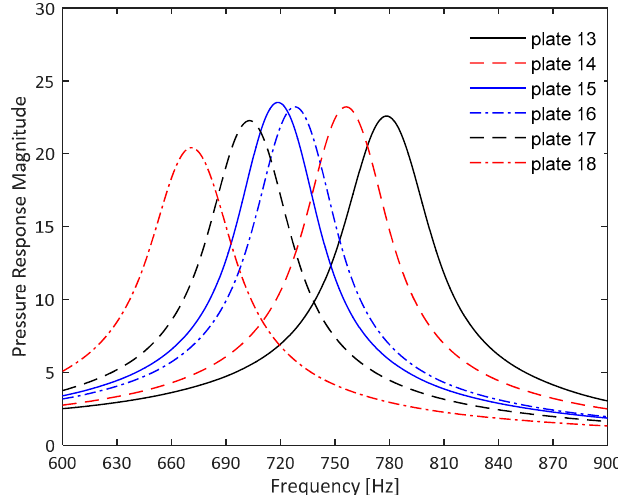
Figure 17. Experimental pressure response functions for plate 13 to plate 18. Table 4. Comparison of experimental and fitted model results for end correction lengths.